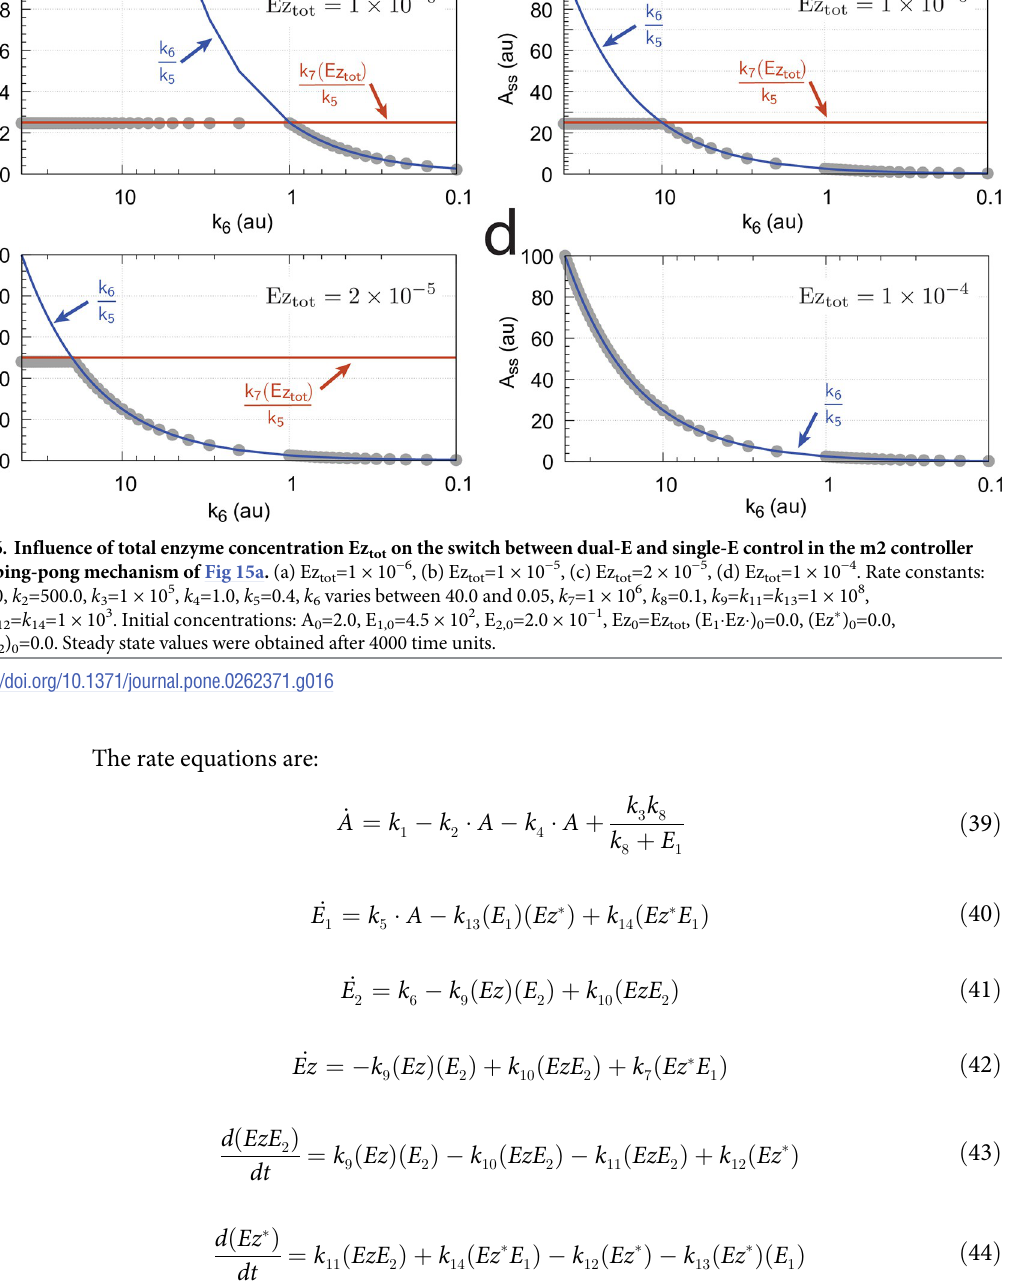
as a function of the rate constants k 6